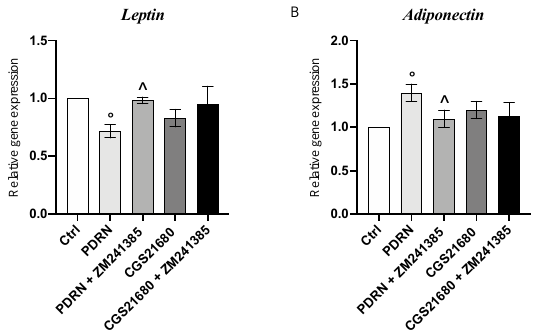
Figure 6. The graphs represent qPCR results of leptin ( A )and adiponectin ( B ) mRNA expression obtained from adipocytes cells. Values are expressed as the means and SD. N = 3 experiments; ° p < 0.05 vs. CTRL; ^ p < 0.05 vs PDRN.